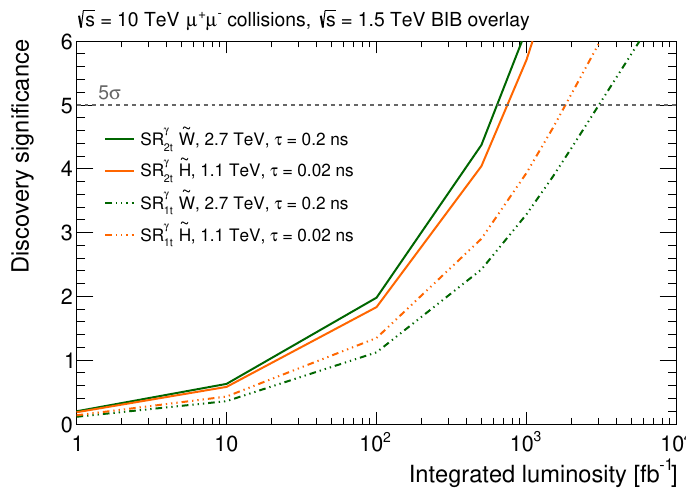
Figure 16. Expected discovery significance as a function of the integrated luminosity in 10 TeV µ + µ − collisions, shown separately for two benchmark signals and each SR selection.